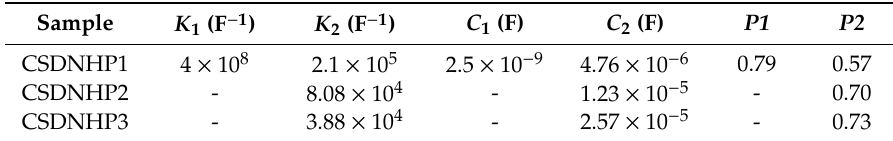
Table 2. The electrical equivalent circuits (EEC) fitting parameters for the CS:DX:NH 4 PF 6 : glycerol systems at room